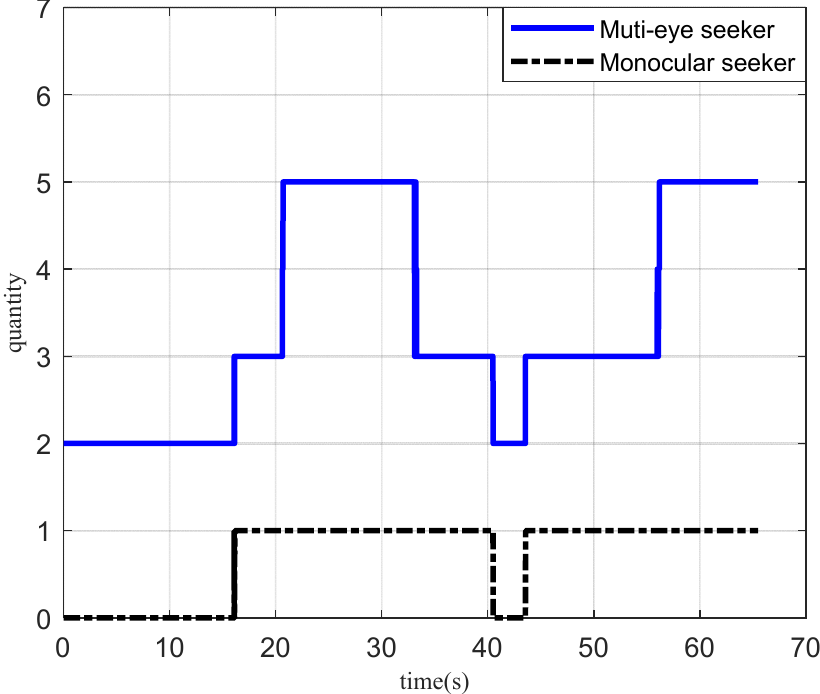
Figure 14. The number of sensors which could detect the target.